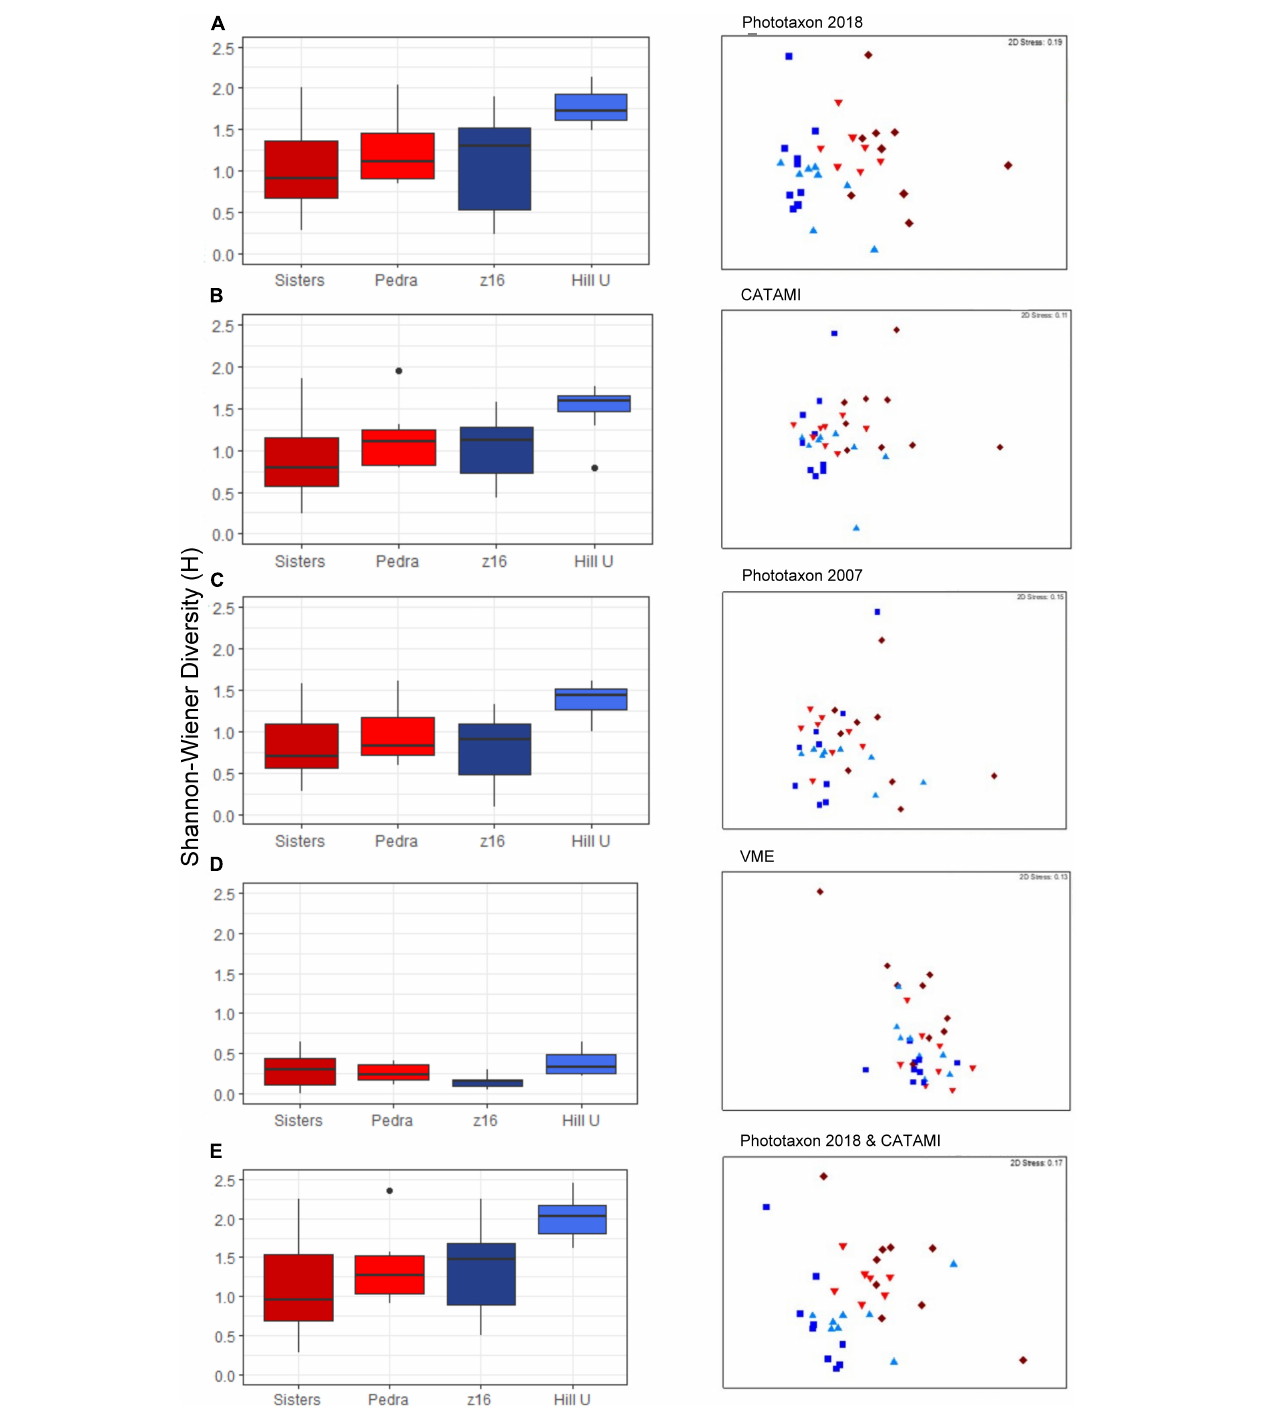
FIGURE 7 | Shannon-Wiener Diversity of coral entities and non-metric multidimensional scaling ( nMDS ) ordination plots of coral entity community patterns on low impact for low impact (blues: Hill U, z16) and high impact (reds: Sisters, Pedra) seamounts, for each of the five classification schemes under consideration.